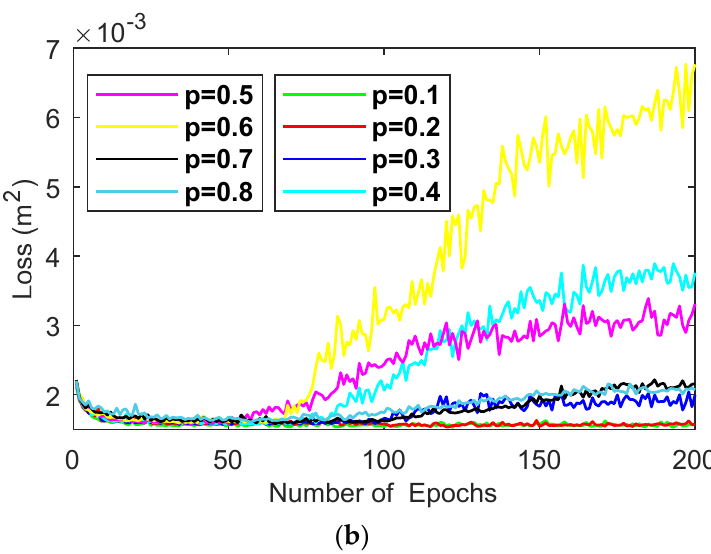
Figure 11. Training error variations under different p − values depending on the number of epochs. ( a ) Variation of the training set error depending on the number of epochs ( b ) Variation of the test set error depending on the number of epochs.